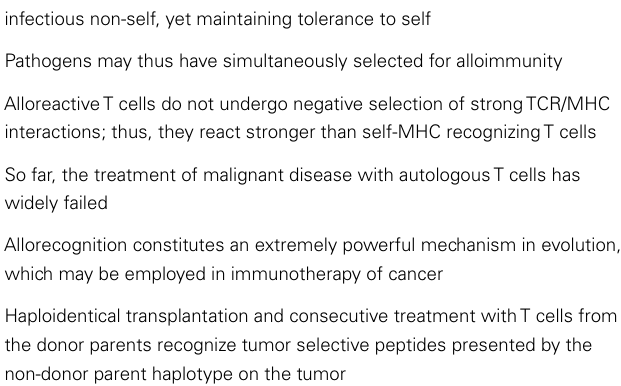
allorestrictedT cells in Immunotherapy of